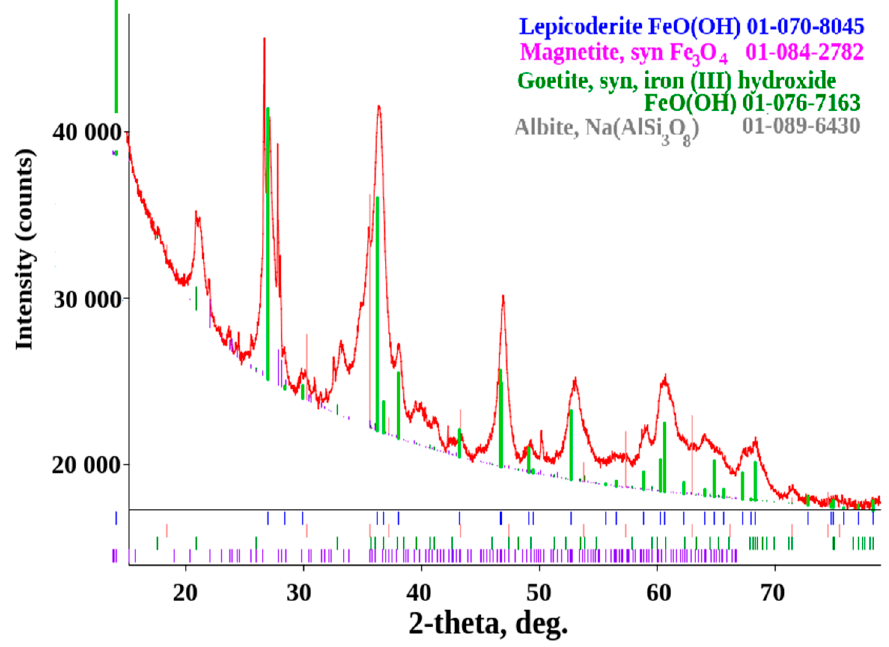
Figure 10. Diffractogram of the of the U7 surface compounds. Vertical bars at the bottom of the graph mark the peak positions of the identified phases.